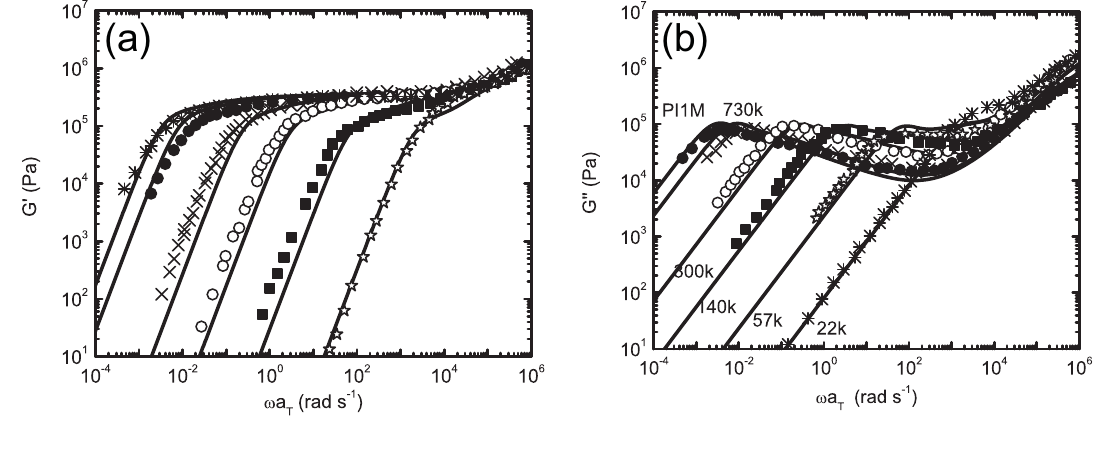
Figure 24. ( a ) Storage, G (cid:48) ; and ( b ) loss, G (cid:48)(cid:48) , moduli of cis-PI polymers with different molecular weights. The solid lines are given by the hierarchical multiscale computational framework. The dots are experimental results taken from [332]. Figure reproduced with permission from